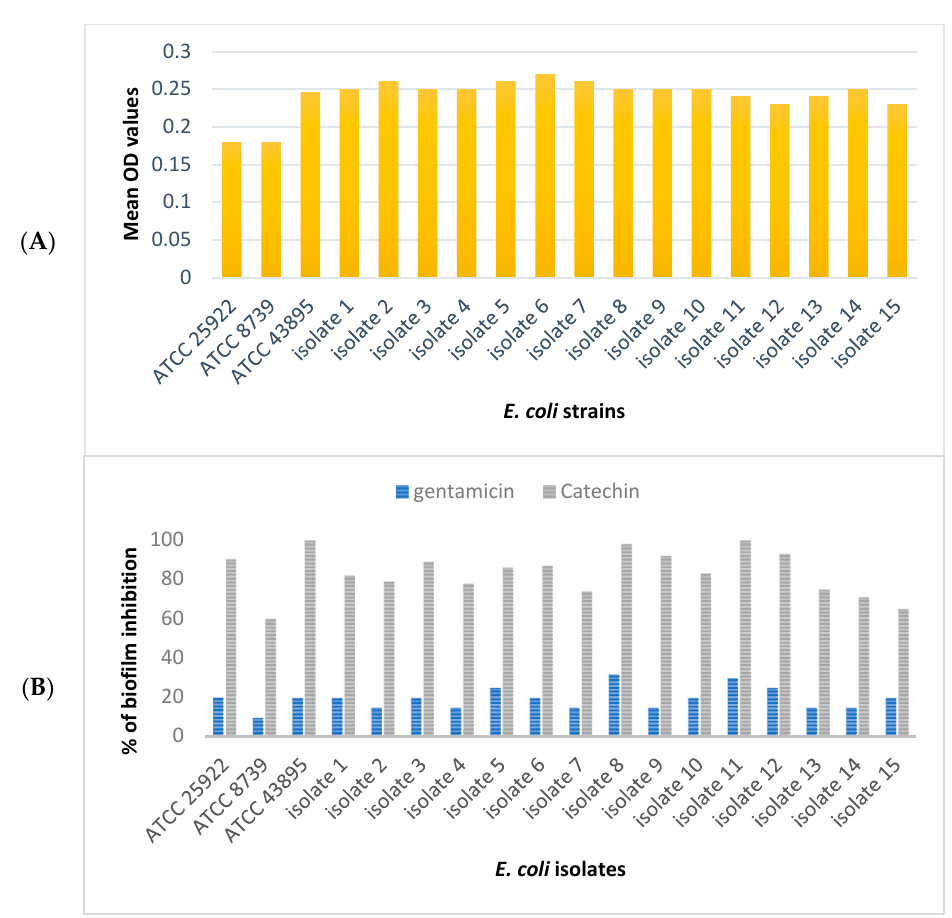
Figure 2. Biofilm formation ability of E. coli ATCC and clinical isolates ( A ), and biofilm inhibition effect of catechin ( B ). Gentamicin is the positive control. All the data were obtained from three independent experiments, and the mean values were presented.